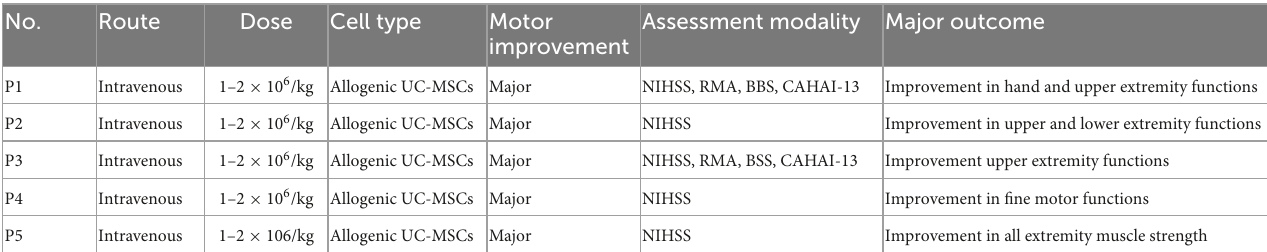
TABLE 3 Clinical outcome of umbilical cord-mesenchymal stem cells (UC-MSC) treatment for stroke.